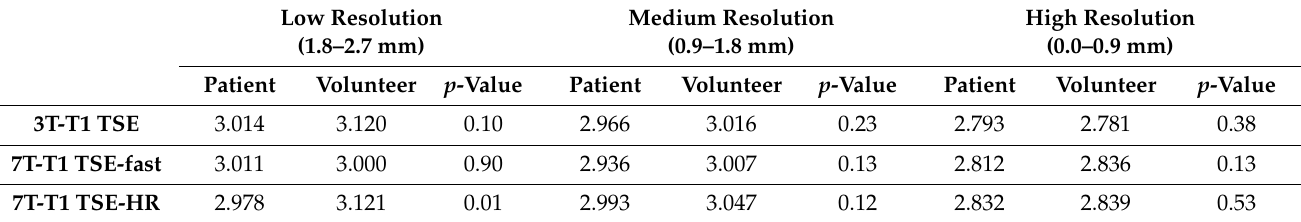
Table 3. Comparison of vertical fractal dimensions between the patient group and volunteer group using 3T and 7T